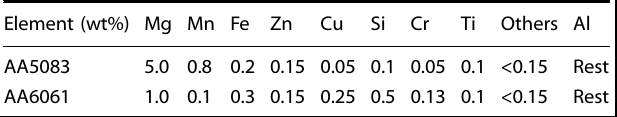
Table 1. Chemical composition of the alloys based on the supplier certi fi